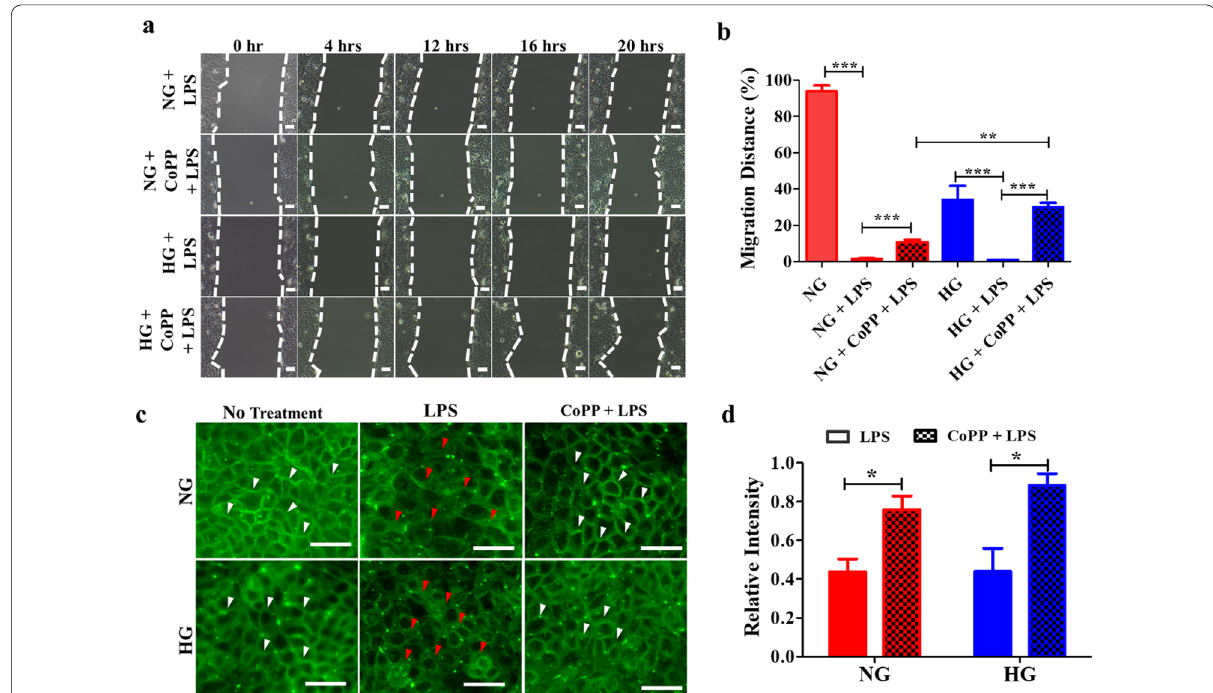
Fig. 6 T he protective effect of CoPP pretreatment in HaCaT after exposing to LPS‑containing media. a Time lapse images showing the migrated distance of CoPP‑pretreated HaCaT after exposing to LPS‑containing media (scale bar, 100 μm), b and the statistical analysis of the migrated distance of each sample at 20th hours of the migration assay. c The fluorescence probing of ZO‑1 expressions in HaCaT that received LPS or CoPP pretreatment plus LPS (scale bar, 50 μm). d Statistic analysis of the fluorescence signals of ZO‑1 in HaCaT that received either LPS or CoPP measured fluorescent intensities were normalized against the respective non‑treatment group. ** P < 0.01; *** P <